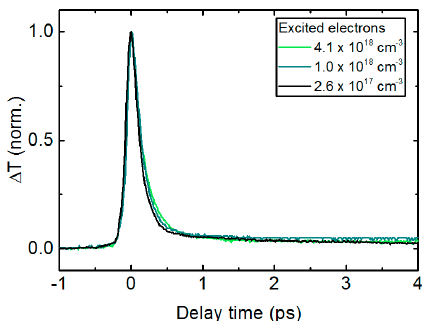
Figure 1. Differential transmission curves of InGaAs:Fe as a function of pump-probe time delay for three different electron densities excited by the 1550 nm pump. InGaAs:Fe features an ultrashort electron lifetime of 250 fs and shows no saturation of the electron lifetime for increasing optical excitation densities.